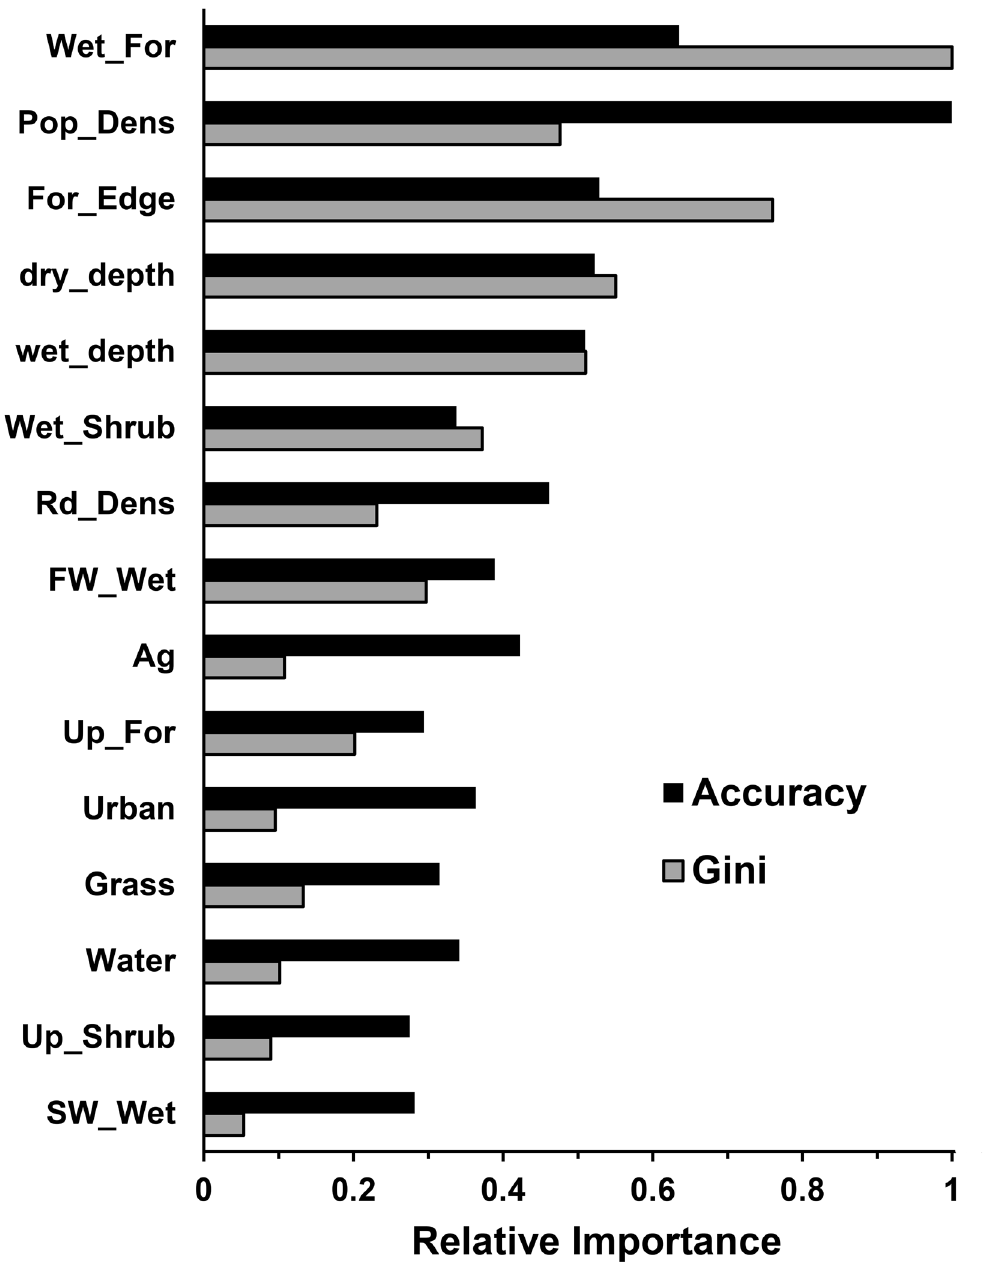
Fig 4. Variable importance. Importance was calculated based on mean decrease in model accuracy (black bars) and mean decrease in Gini index (gray bars). Importance scores were standardized relative to the most important variable by each method. Variables are ranked from highest to lowest importance, based on combined scores from the two methods. Wet_For = wetland forest, Pop_Dens = human population density, For_Edge = forest edge, dry_depth = average dry season water depth, wet_depth = average wet season water depth, Wet_Shrub = wetland shrub, Rd_Dens = road density, FW_Wet = open freshwater wetlands, Ag = agricultural, Up_For = upland forest, Grass = grasslands/dry prairies, Water = open water, Up_Shrub = upland shrub, SW_Wet = saltwater wetland.